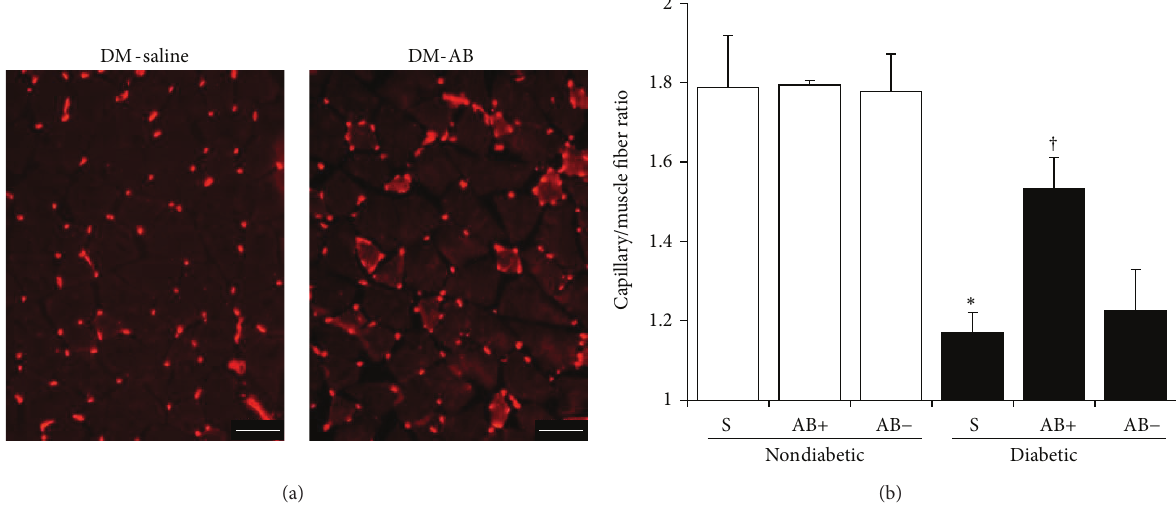
Figure 6: Capillary number to muscle fiber ratios in soleus muscles. (a) The vasculatures were visualized by Alexa594-conjugated isolectin IB4 in soleus muscles. More capillaries existed in soleus muscle of transplanted diabetic mice (right) compared to those of nontransplanted control diabetic mice (left). Red: isolectin IB4. Bar: 50 𝜇 m. DM-saline: saline-injected limb in diabetic mice and DM-AB: limbs transplanted angioblast-like cell derived from ES cells in diabetic mice. (b) Quantitative analyses revealed that the capillary number to muscle fiber ratios in the saline-injected sides of diabetic mice were significantly reduced compared with those of normal mice (N). Transplantation of angioblast- like cell derived from ES cells (ES-ABs) significantly augmented the ratios in transplanted limbs compared with those in saline-injected side limbs in diabetic mice (DM). Transplantation of ES-ABs into normal mice showed no significant differences. S: saline treated limbs, AB+: limbs transplanted ES-ABs, and AB − : contralateral limbs transplanted ES-ABs. Results are means ± SD. ∗ 𝑃 < 0.05 versus S in N (N-S) and † 𝑃 < 0.05 versus S in DM (DM-S). 𝑁 = 4 in N-S and 𝑛 = 3 in DM-S ( 𝑃 = 0.0004 ). 𝑁 = 3 of AB+ in DM and 𝑛 = 5 of AB − in DM ( 𝑃 = 0.0276 represents DM-S versus AB+ in DM). 𝑁 = 4 of AB+ in N and 𝑛 = 4 of AB − in N ( 𝑃 = 0.9609 represents N-S versus AB+ in